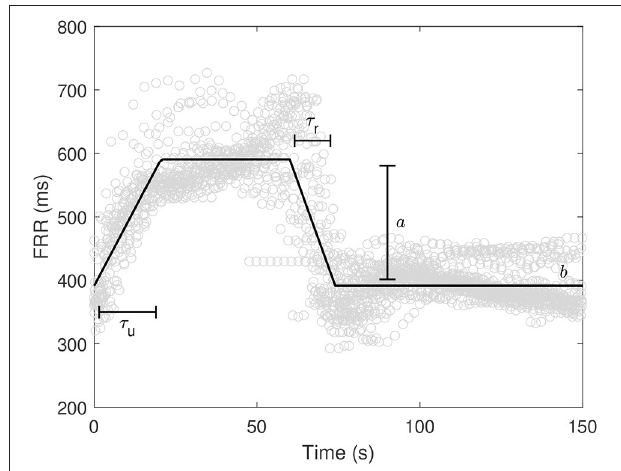
FIGURE 1 | Example of model fitting along with variable definition. ◦ refers to FRR values from the beginning of the UCOs.